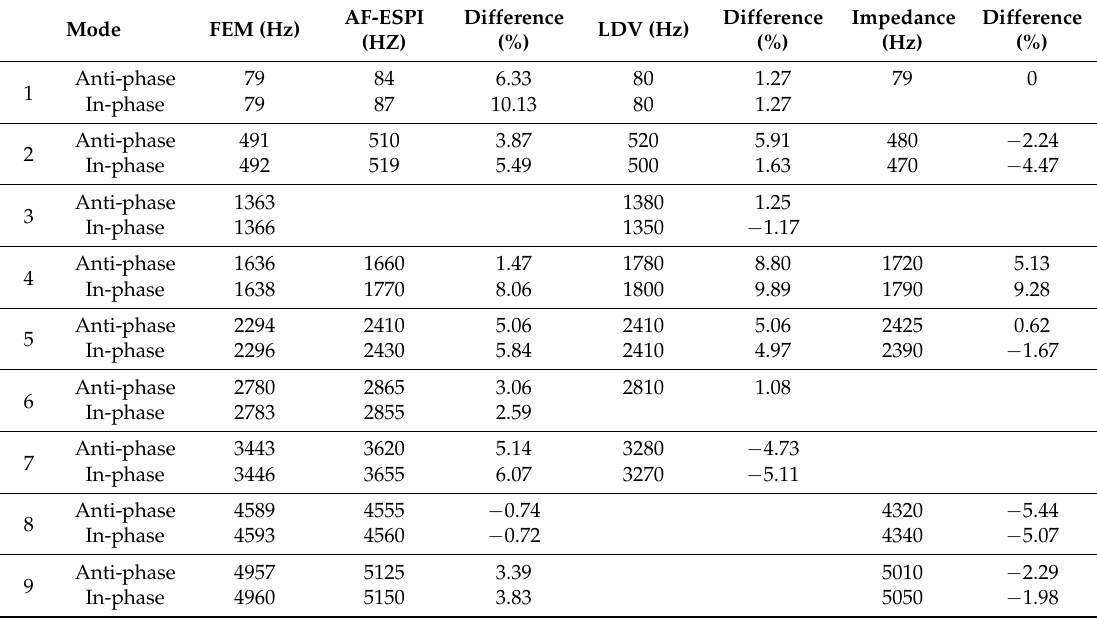
Table 3. Resonant frequencies of piezoelectric valveless micropumping element under air-coupled conditions. LDV: laser Doppler vibrometer.